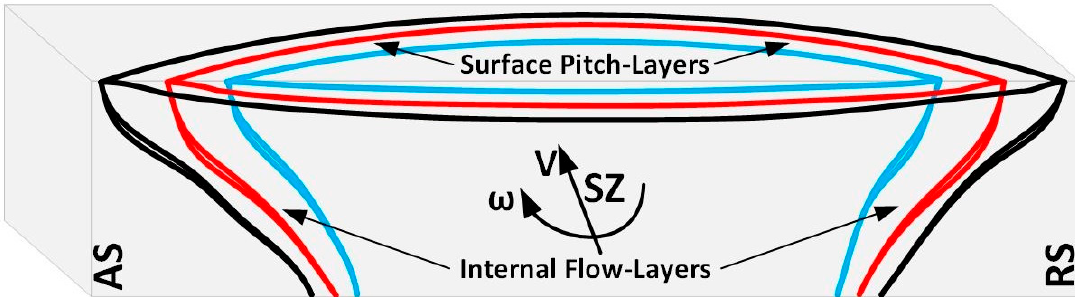
Figure 14. The proposed flow patterns for the flow-arms and the weld pitch patterns at the cross-section and surface of the weld region, respectively. The model aims to reveal the flow lines during the revolution of the tool and deposition of the layered mass at the trailing edge of the tool.